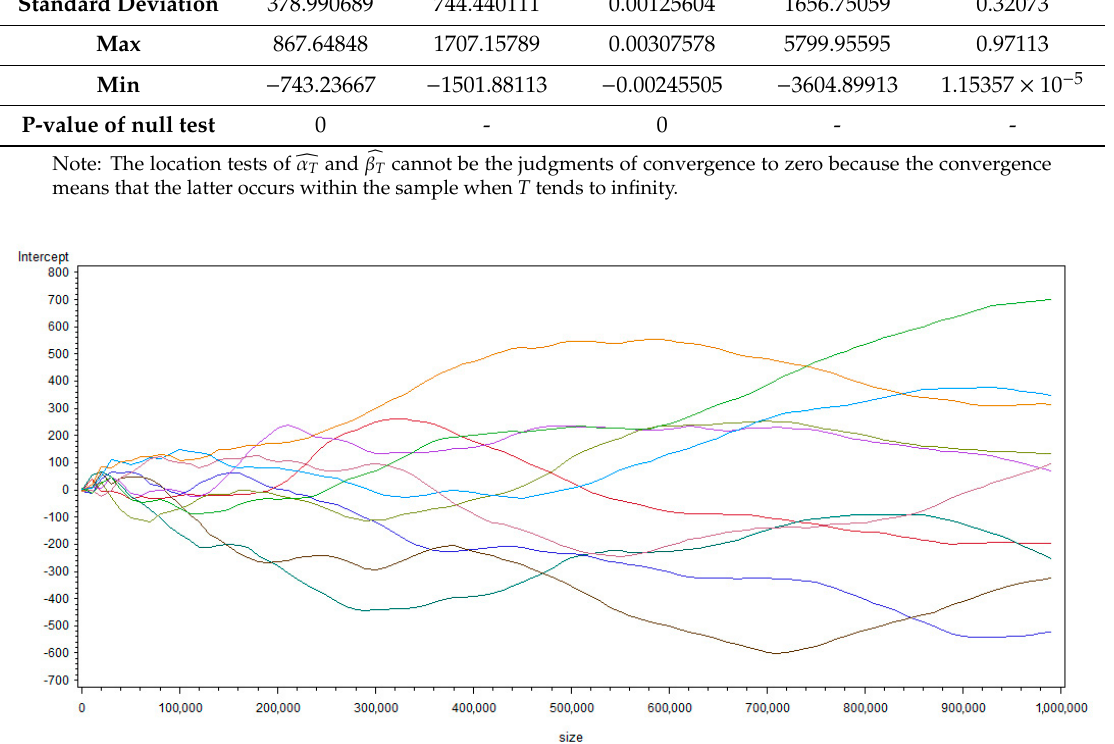
Figure 1. Evolutions of 𝛼 (cid:3021) (cid:3550) when the sample size increases from 100 up to 1,000,000.